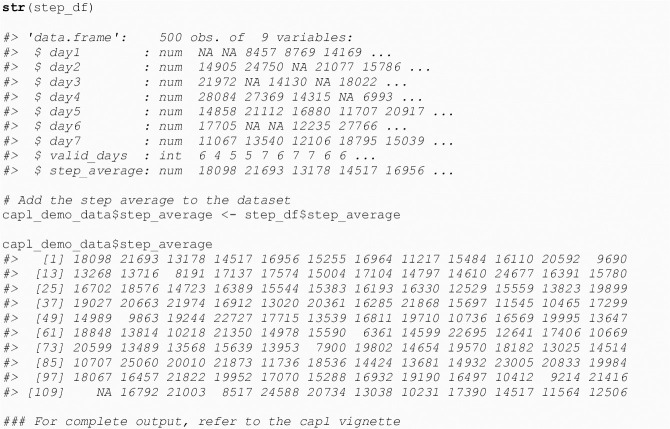
Calculate daily step average.